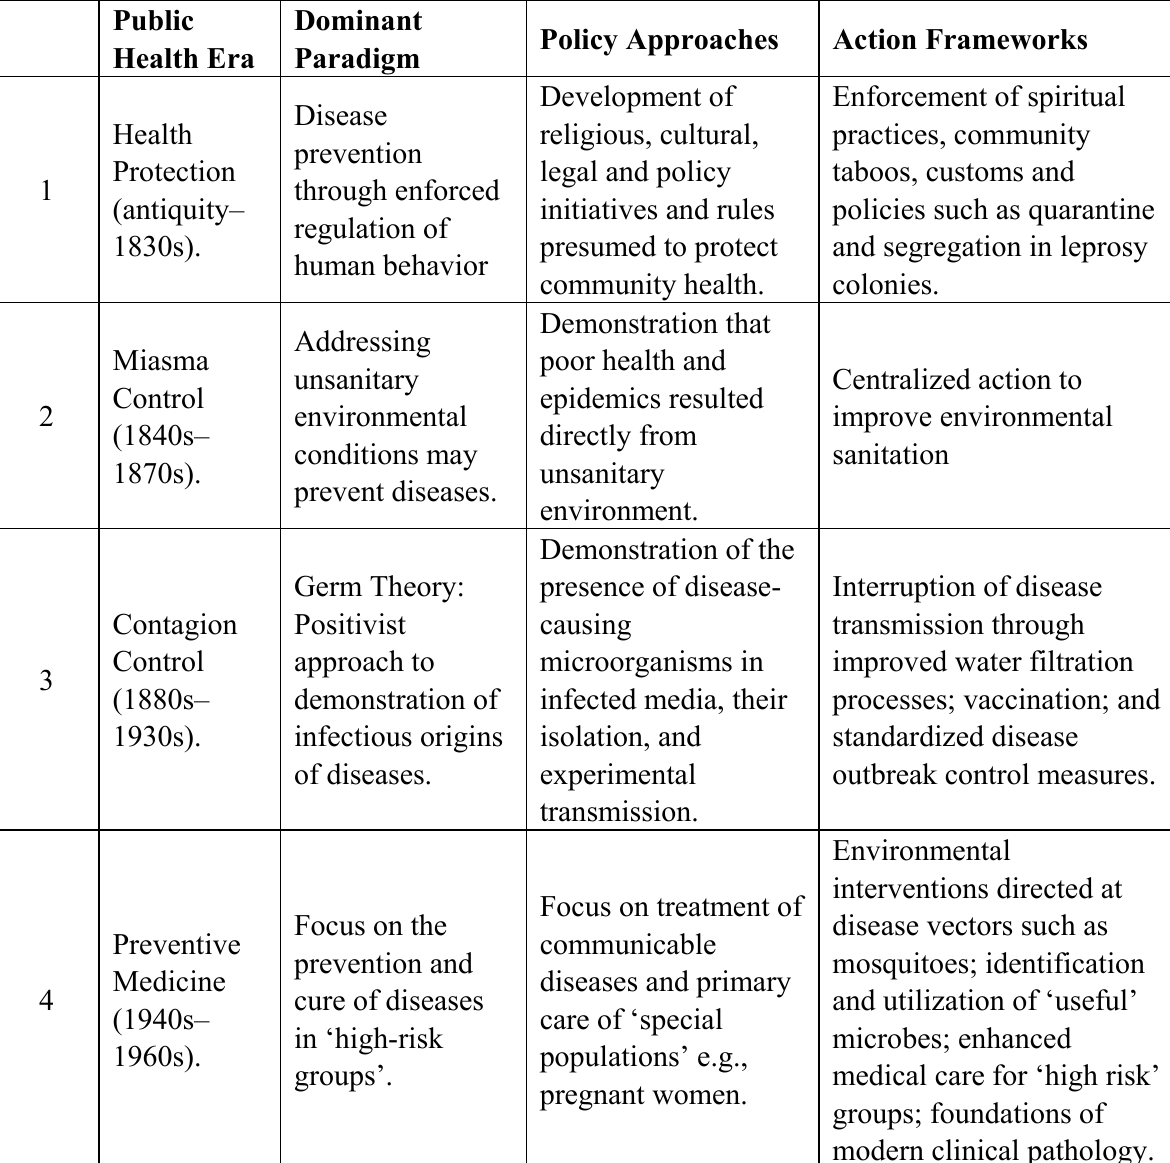
Table 1. Public health eras and associated policy